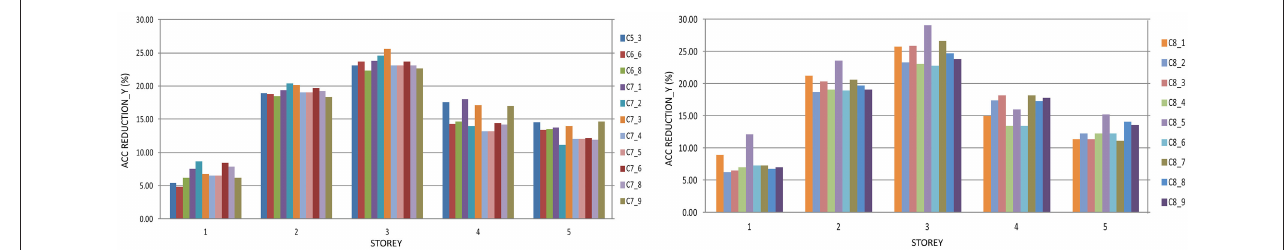
FIGURE 12 | Reduction of accelerations per stories of the structure with the optimal solutions from the fifth, sixth, seventh and eighth cycle compared with the structure without dampers in Y direction.